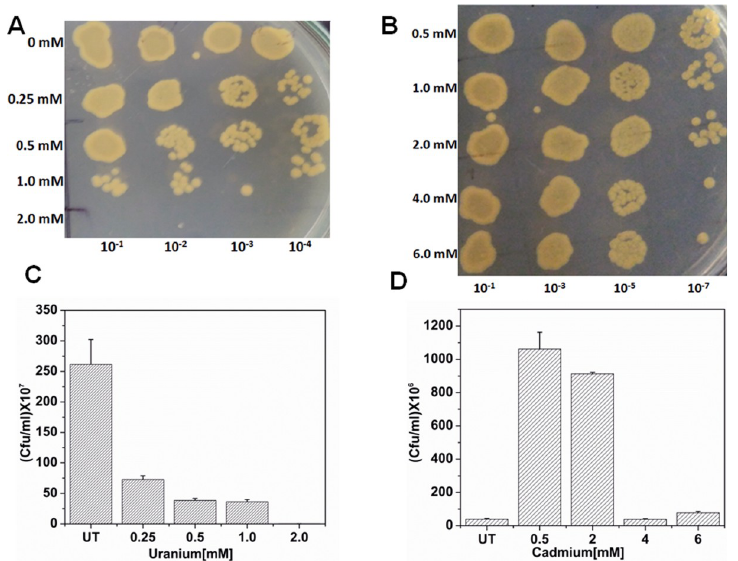
Fig 1. Growth of Chryseobacterium sp. after treatment with various concentrations of metal. A) Spot assay to determine the MIC towards Uranium; B) Plating method to determine the effect of U on Chryseobacterium sp.; A) Spot assay to determine the MIC towards Cd; B) Plating method to determine the effect of Cd on Chryseobacterium